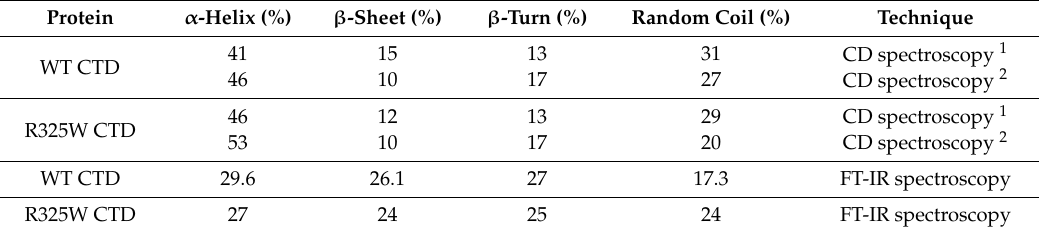
Figure 5. Analysis of the secondary structure content of the hZnT8 CTDs by Fourier transform infrared (FT-IR) spectroscopy. ( a , b ) The second derivative and amide I region of FT-IR spectra of a hydrated film of the WT CTD ( a ) and the R325W CTD ( b ) are shown as thick grey lines. The bands obtained by deconvolution are also depicted. The dotted red line represents the curve fitted using the component bands. The peak position of the spectral components and their assignments are also shown. Table 1. Secondary structure content of the WT CTD and the R325W CTD analyzed through spectroscopic techniques in the current